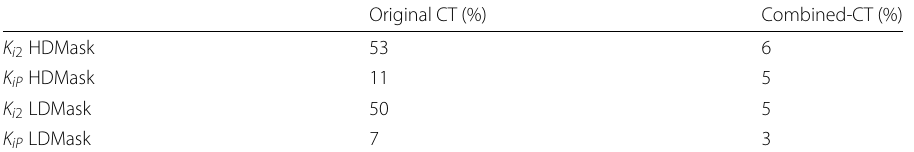
Table 4 The average parameter estimate errors as a fraction of the average parameter estimate for the FDG patients using the original acquired CTs and the combined-CTs for AC in the PET reconstruction at each study stage Original CT (%) Combined-CT (%) K i 2 HDMask 53 6 K iP HDMask 11 5 K i 2 LDMask 50 5 K iP LDMask 7